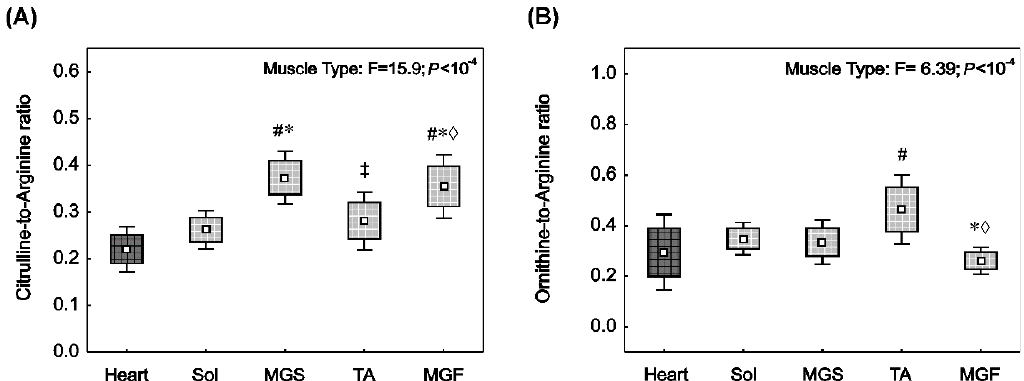
Figure 2. Nitric oxide synthase activity (reflected by citrulline ‐ to ‐ arginine ratio) and arginase activity (reflected by ornithine ‐ to ‐ arginine ratio) in rat striated muscles with varied muscle fibre type composition. Citrulline ‐ to ‐ arginine ratio ( A ) and ornithine ‐ to ‐ arginine ratio ( B ) in the heart (dark square) and in the locomotory muscles (bright squares) i.e., soleus (Sol), slow part of medial gastrocnemius (MGS), tibialis anterior (TA) and fast part of medial gastrocnemius (MGF). Boxes and whiskers represent, correspondingly, the 95% confidence intervals for means and the standard deviations in samples of 12 animals for each studied muscle tissue (i.e., heart, Sol, MGS, TA and MGF). The impact of muscle type on the analysed variables is presented. Results of one ‐ way ANOVA and Tukey post ‐ hoc are shown in ( A ), whereas Welch ANOVA and post ‐ hoc Games–Howell results are shown in ( B ). # denotes significant difference to the heart; * denotes significant difference to the Sol; ‡ denotes signi fi cant di ff erence to MGS; ◊ denotes signi fi cant di ff erence to TA.